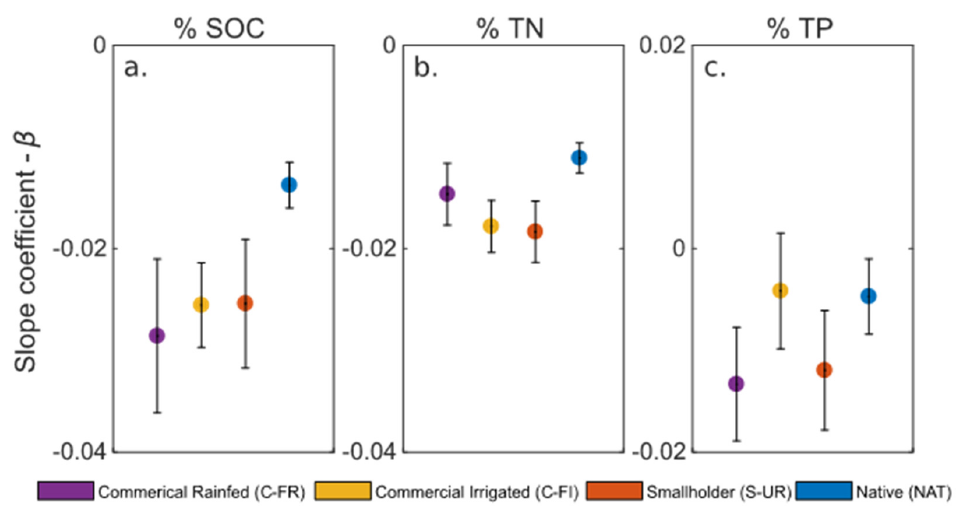
Figure 2. Slope coefficients ( β ) for a fitted single term exponential model (y = ae β x ) for: ( a ), % SOC; ( b ), % TN; ( c ), % TP. More negative values indicate steeper vertical declines in element concentrations. Colored circles along the x -axis of each pane denote the results for each LMP, circles represent the estimated β values for each LMP, black whiskers are the related standard errors (n = 5).